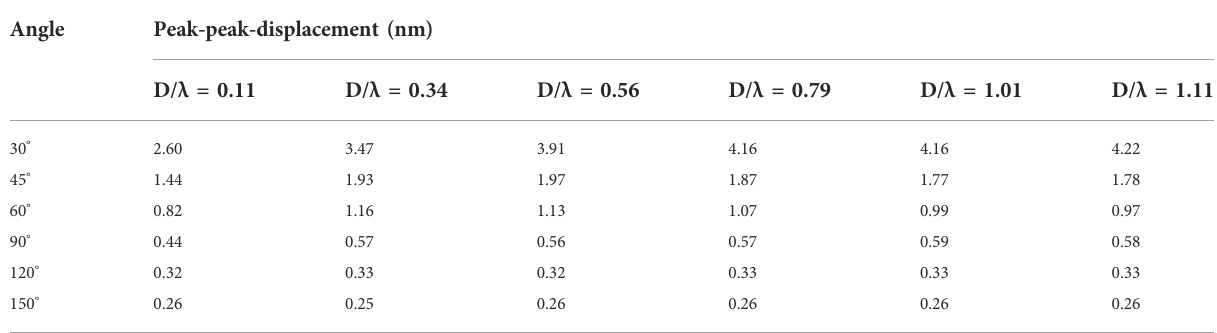
TABLE 3 Peak-peak vlaue of different